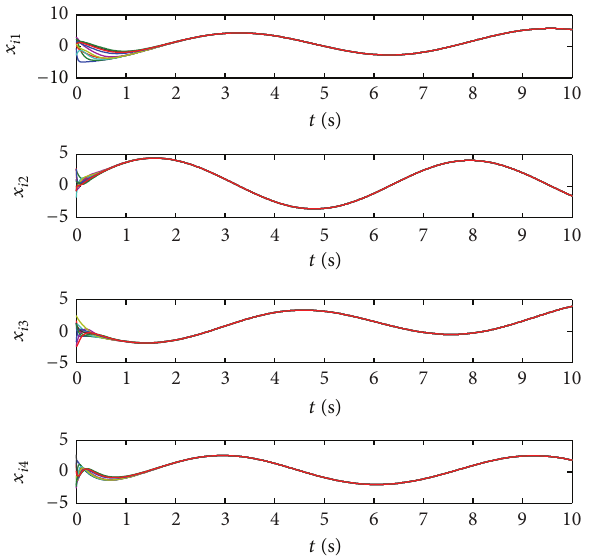
Figure 3: State evolutions of complex network with partial-state